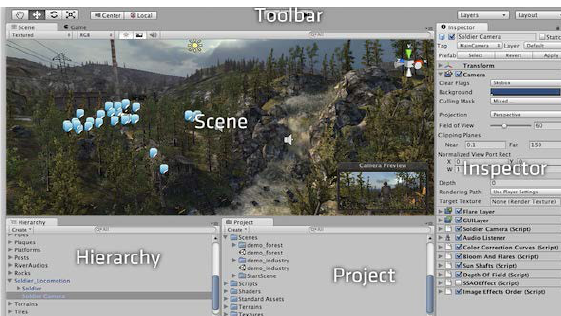
Figure 6: The main Interface and Views of Unity